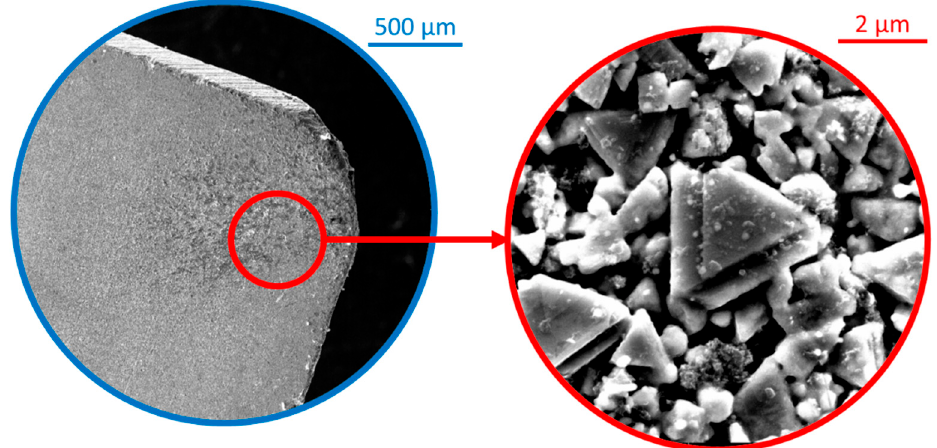
Figure 11. Faceted growth of DLC coating on the tungsten carbide (WC) tool inserts is encircled and enlarged.